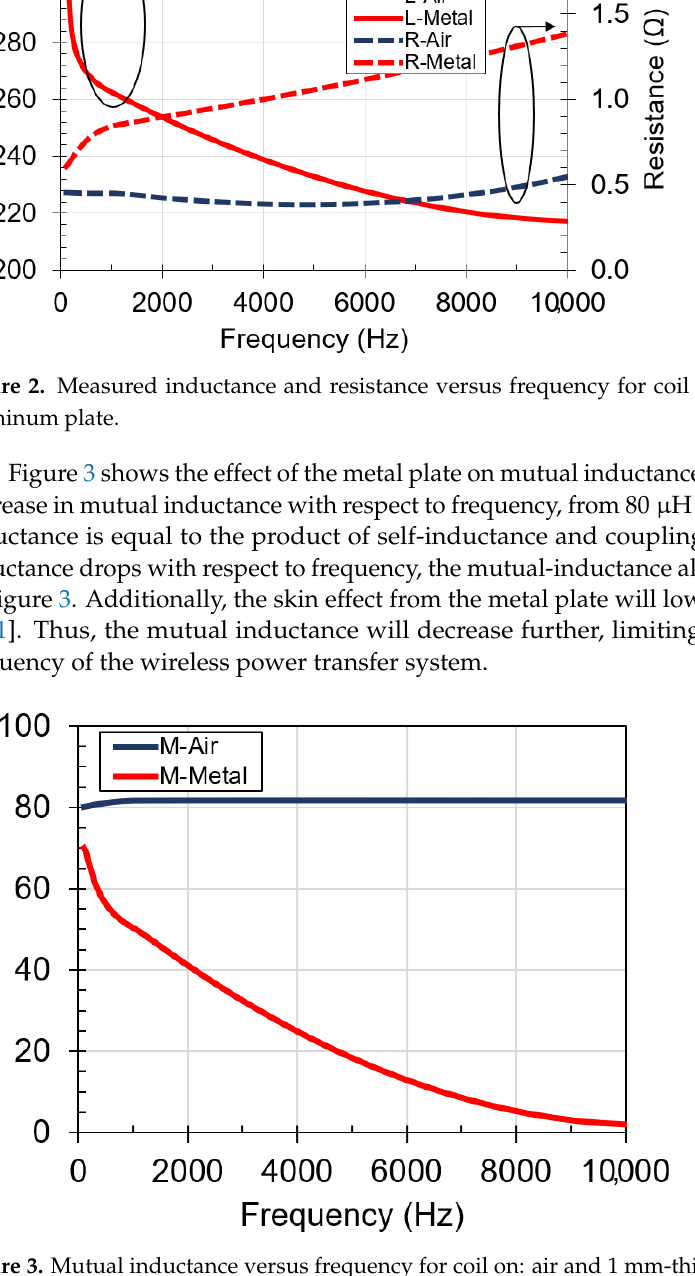
Figure 3. Mutual inductance versus frequency for coil on: air and 1 mm-thick aluminum plate.